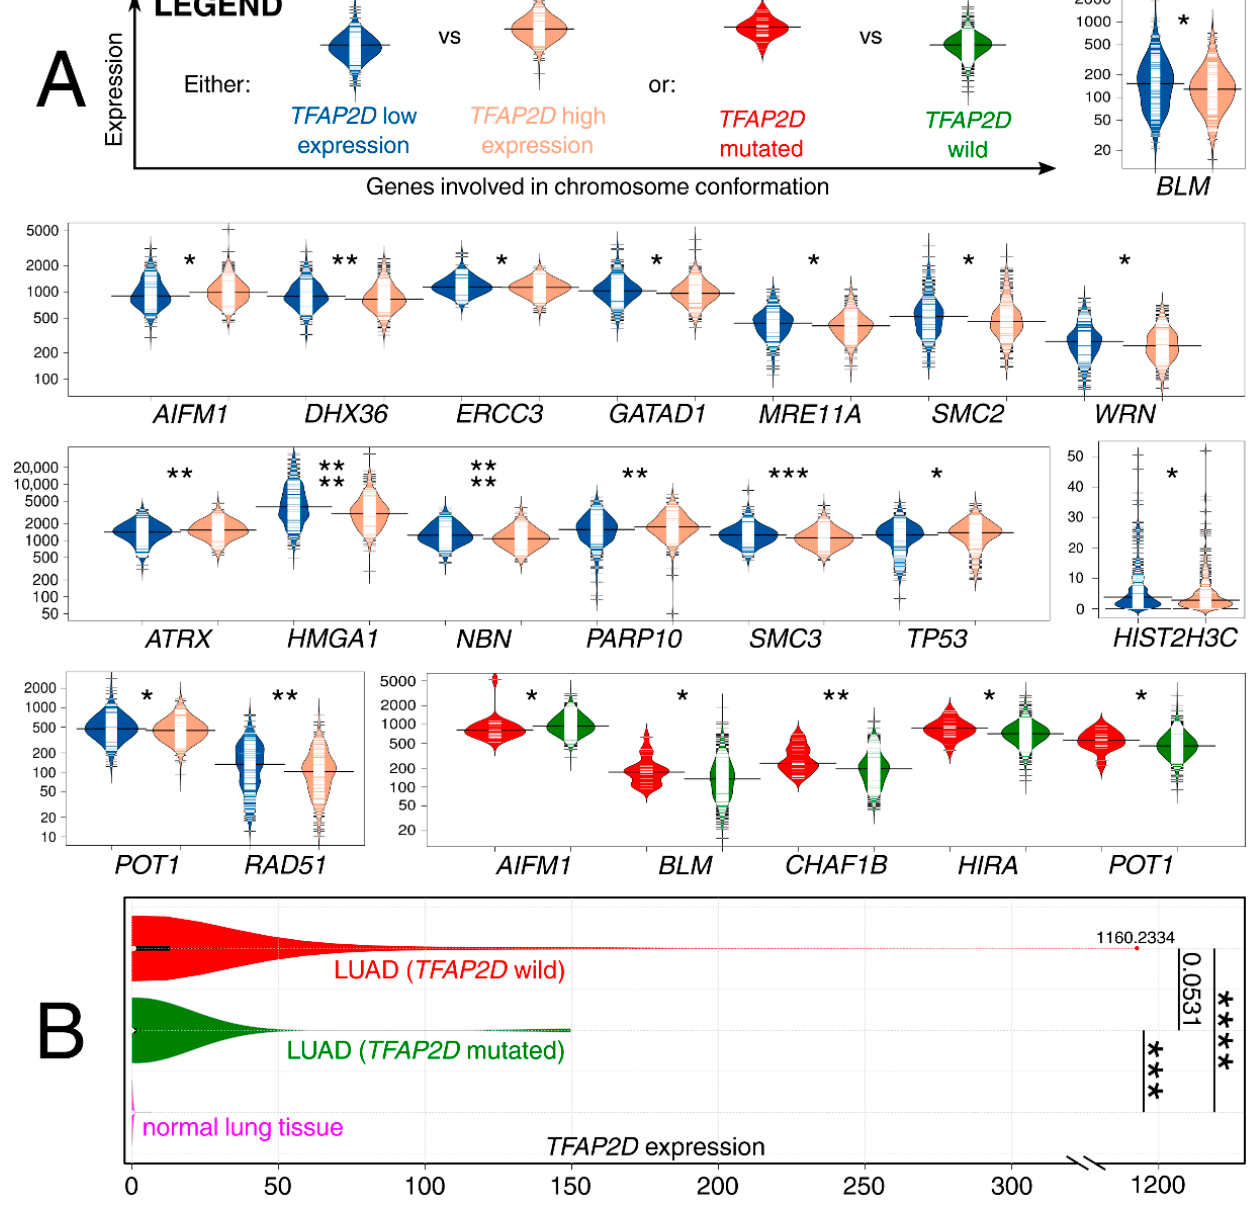
Figure 11. Co-dependence of genes involved in chromosome conformation and either TFAP2D mutation or expression. ( A ) Some genes are on separate scales due to large differences in expression levels. ( B ) TFAP2D expression was also compared between LUAD (separately for samples with TFAP2D wild-type or mutated) and normal lung samples. p < 0.05 (*), p < 0.01 (**), p < 0.001 (***), p < 0.0001 (****). Data acquired from The Cancer Genome Atlas and Genomic Data Commons Portal.